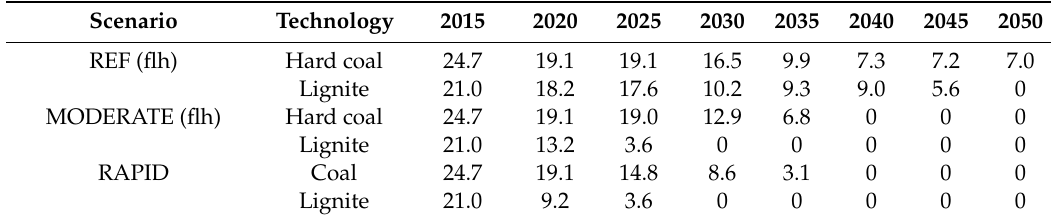
Table 1. Hard coal and lignite capacities in the reference scenario REF and the investigated coal phase-out pathways with or without full load hour restrictions. Note that the scenarios REF and REF-flh, as well as the MODERATE and MODERATE-flh are based upon the same assumptions on available hard-coal and lignite capacities, respectively (own calculations).